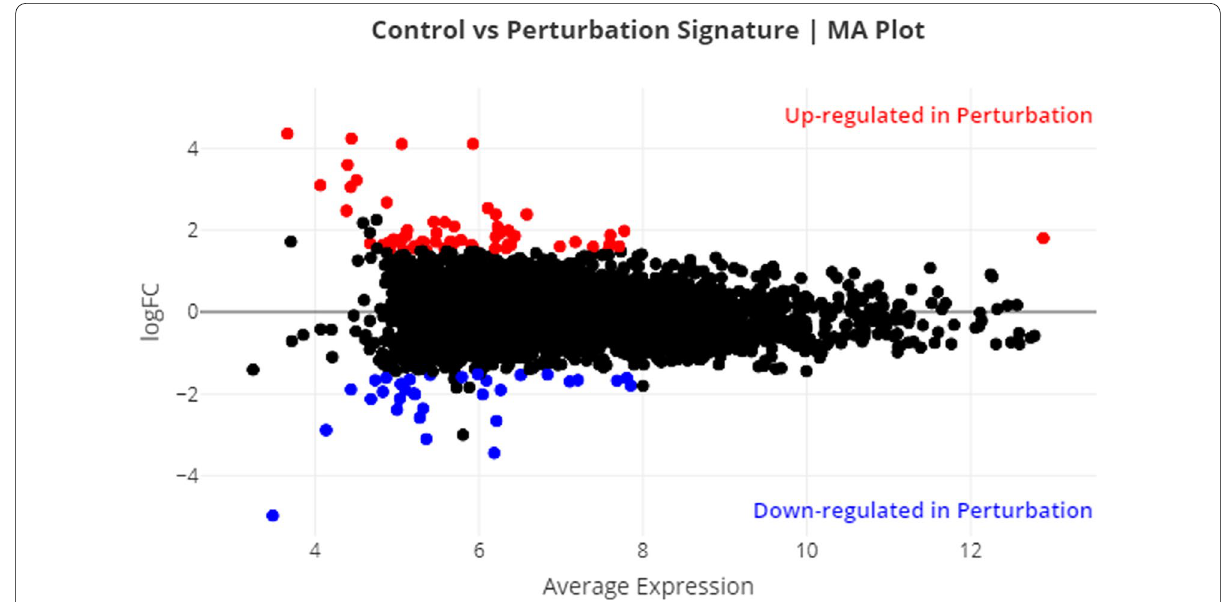
Fig. 1 The figure contains an interactive scatter plot which displays the average expression and statistical significance of each gene calculated by performing differential gene expression analysis. Every point in the plot represents a gene. Red points indicate significantly upregulated genes, and blue points indicate downregulated